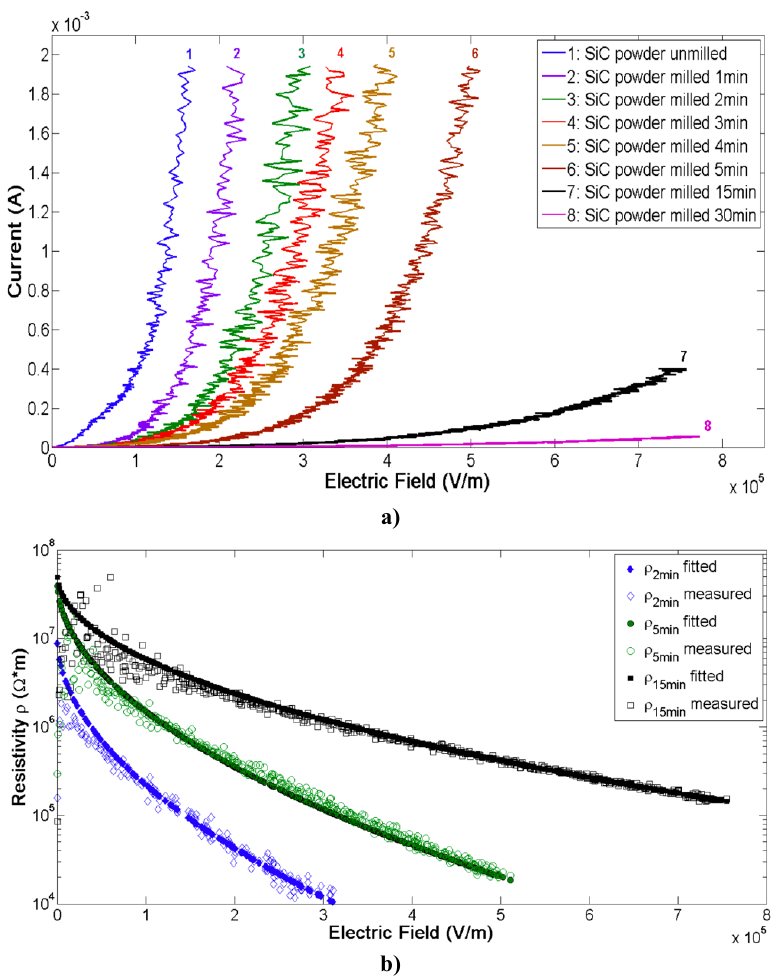
Figure 17. Electrical characterization of SiC powders for different milling times. ( a ) Current vs. electric field, ( b ) resistivity vs. electric field. © 2021 IEEE. Reprinted, with permission, from [63].